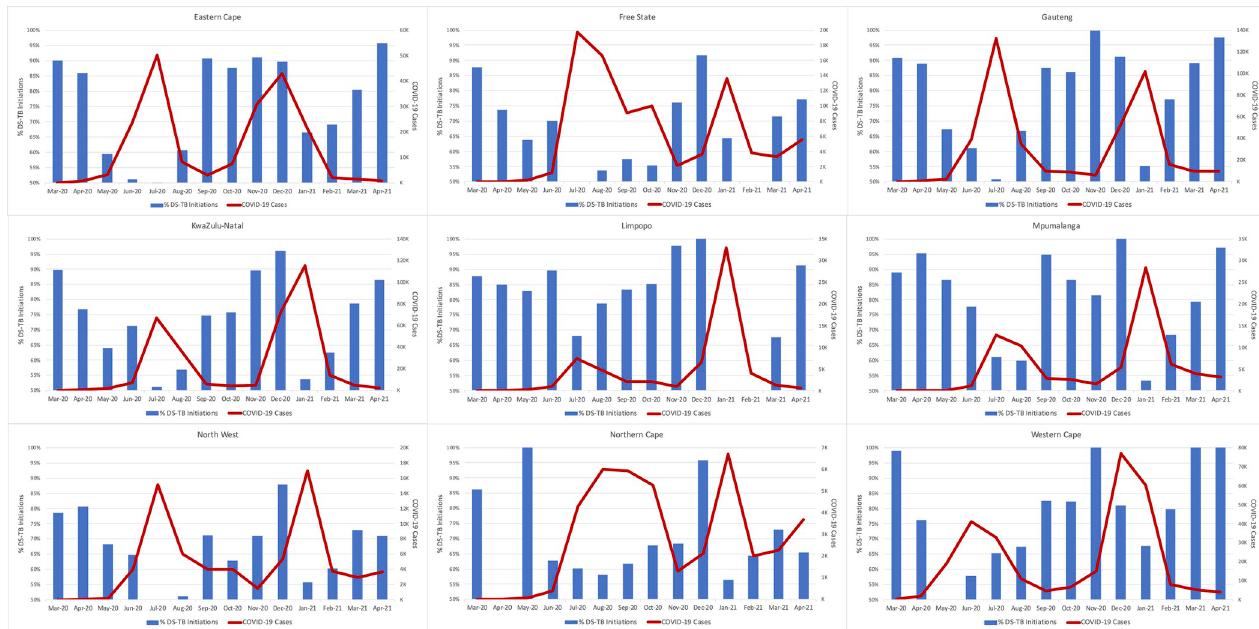
Fig 6. Proportion TB treatment initiations compared to the same month in 2019 and new COVID-19 cases per month, March 2020-April 2021, by